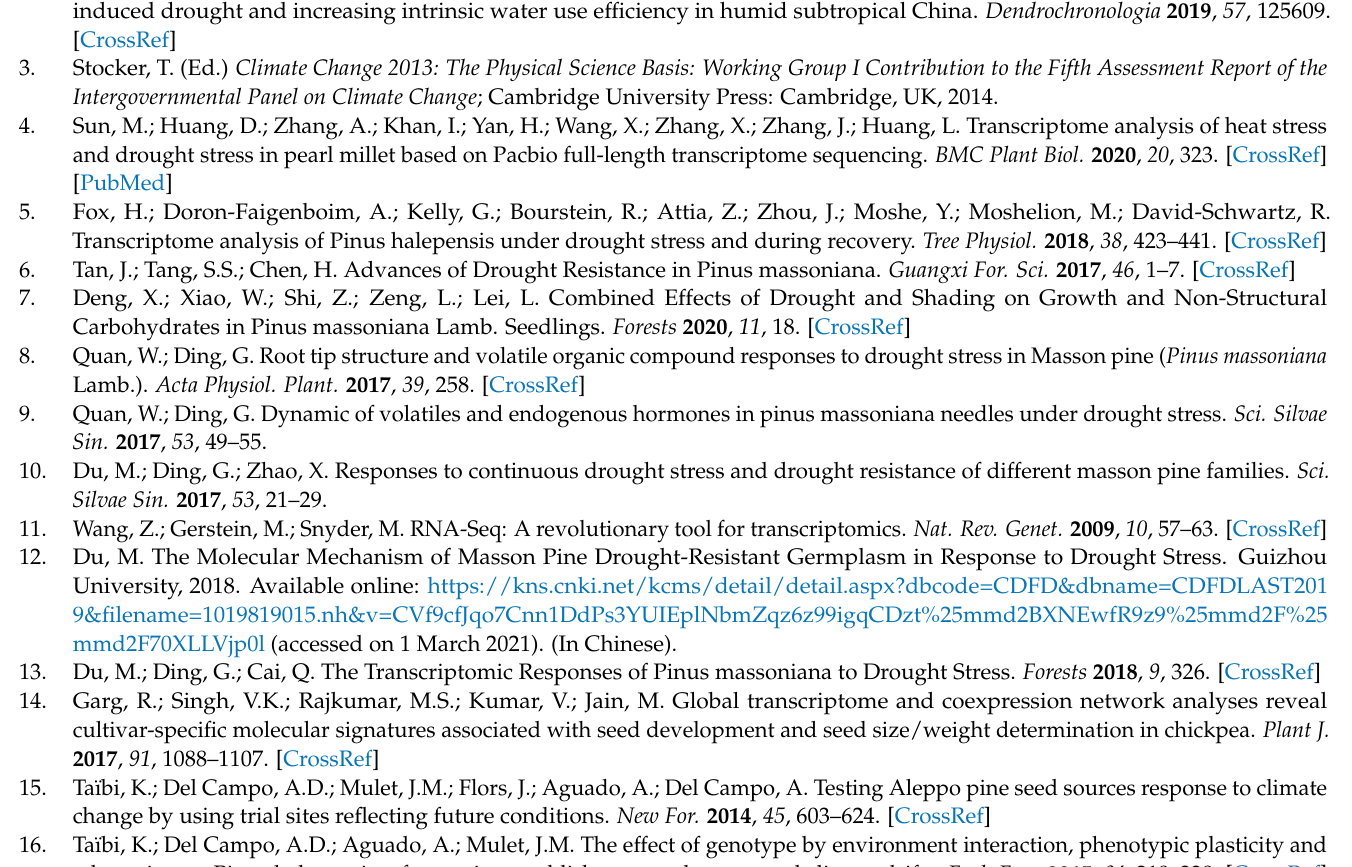
different periods. Figure S2. Venn diagrams of DEGs of P. massoniana in different periods. ( a ) Venn diagram of DEGs at different stages of needles in P. massoniana ; ( b ) Venn diagram of DEGs between needles and roots at different stages; ( c ) Venn diagram of DEGs at different stages of roots in P. massoniana. Figure S3. KEGG enrichment of DEGs in needles and roots in different periods. Note: Each combination selects 10 groups, from small to large, according to p